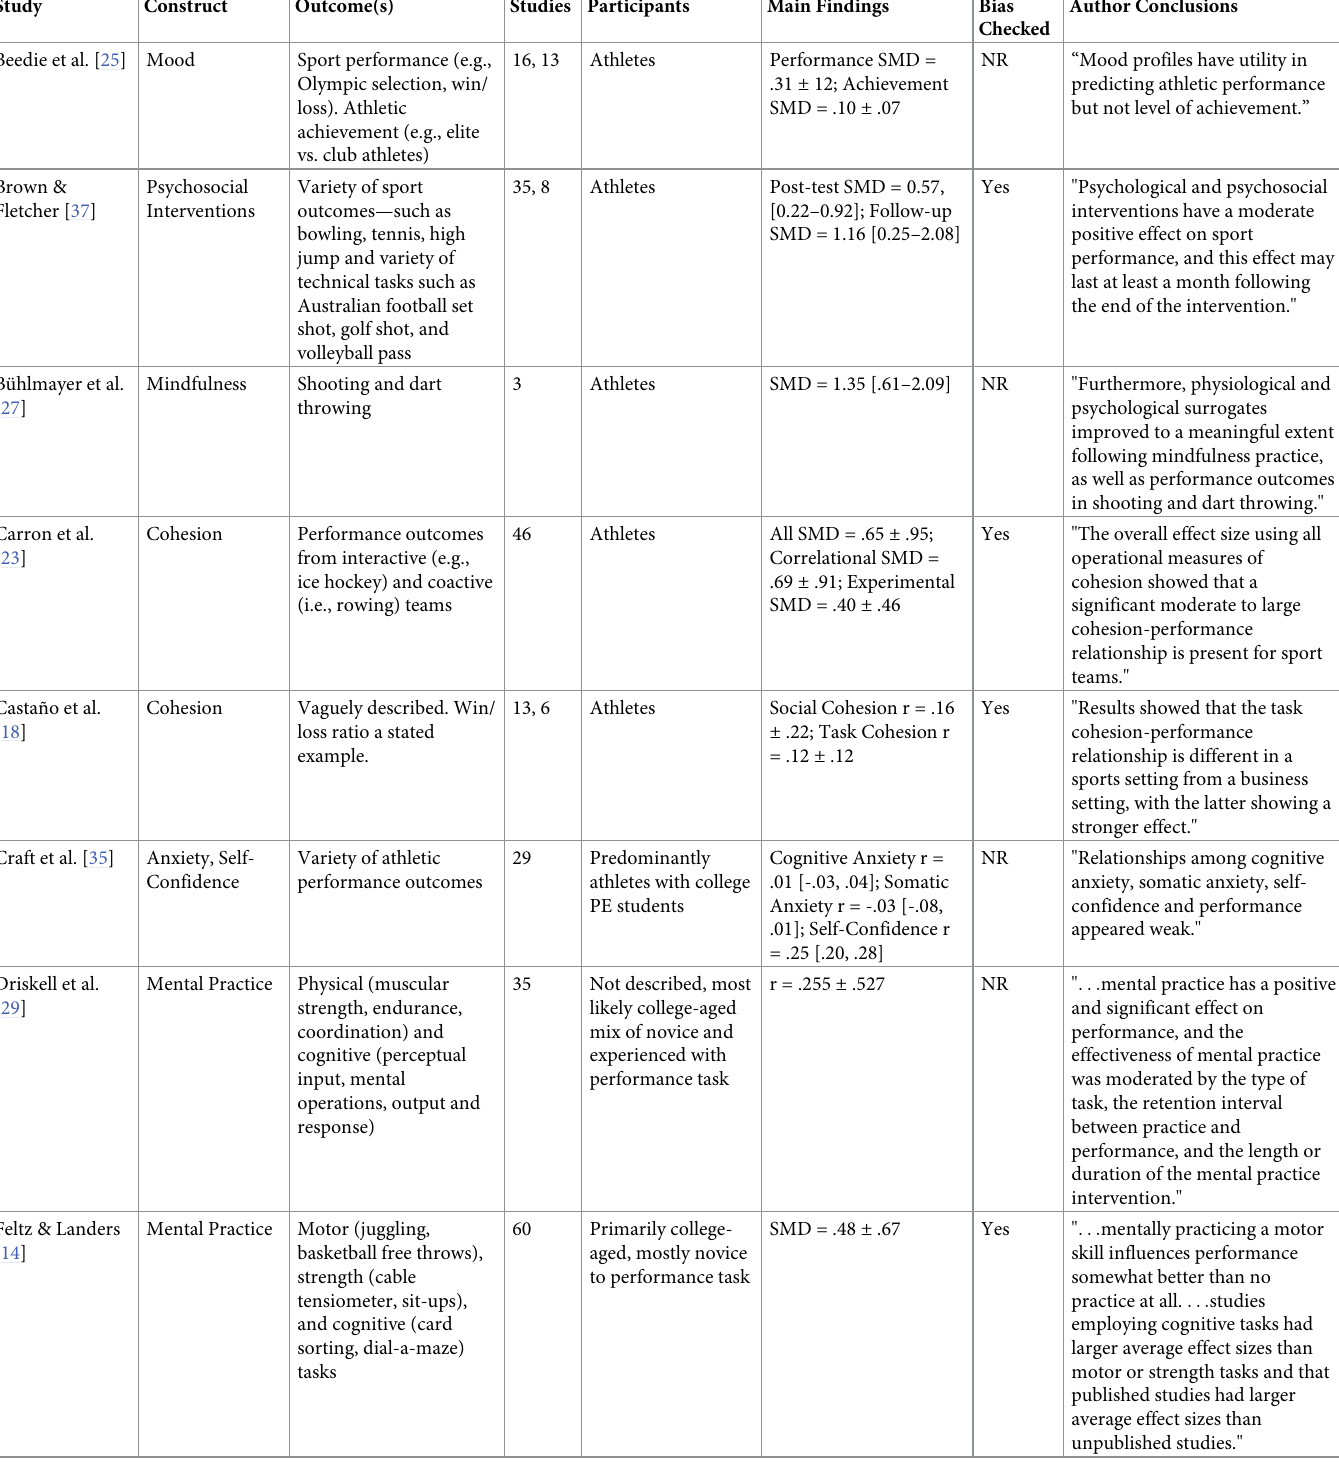
Table 1. Citation, construct, outcome(s), number of primary studies, type of participants, main findings, bias correction, and author conclusions for 30 meta-